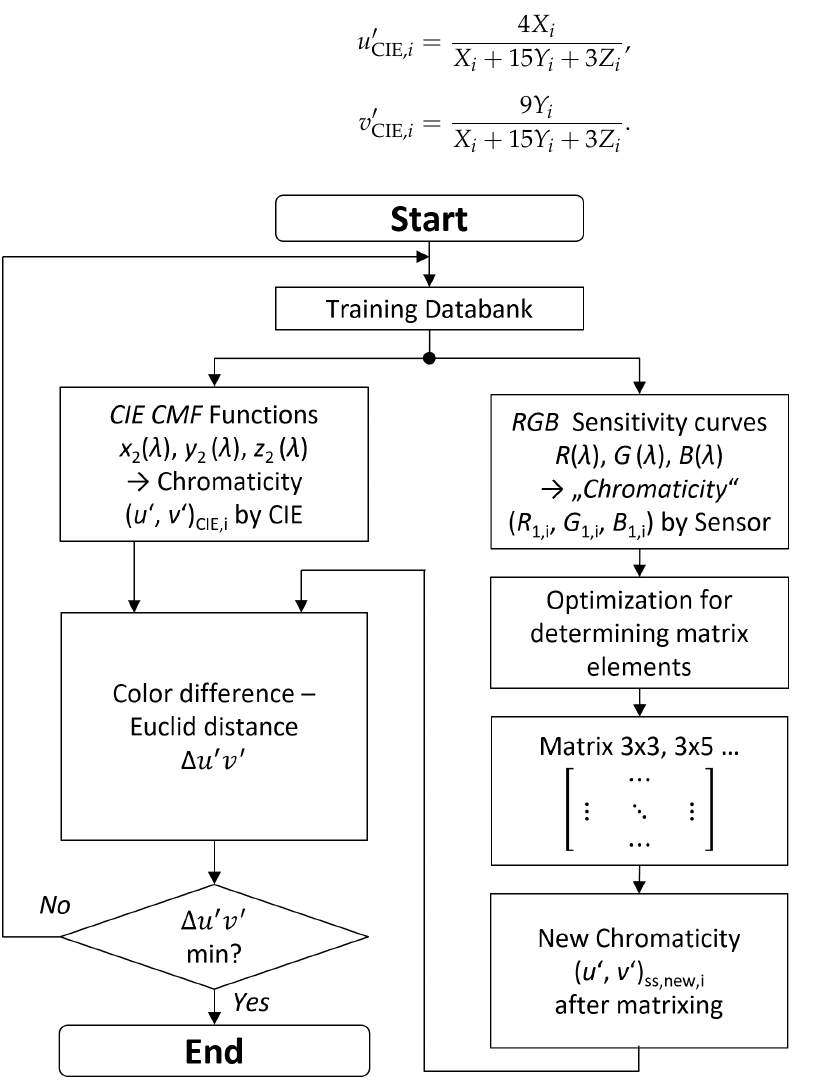
Figure 7. Optimization workflow used to find an optimal transformation matrix to map from the color sensor’s RGB output to CIE XYZ tristimulus